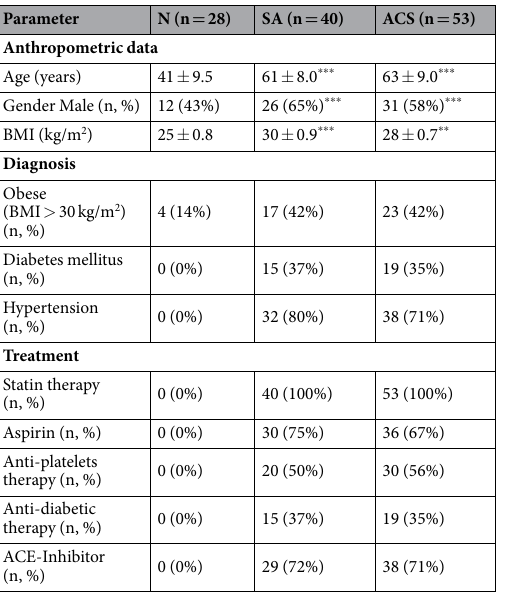
Table 1. Clinical characteristics of CAD patients and healthy subjects. N - healthy subjects, SA - stable angina patients and ACS - acute coronary syndrome patients; n - number of subjects, BMI - body mass index. Data for age are expressed as means ± standard deviation (SD). The BMI data are expressed as means ± standard error of the mean (SEM) and analyzed with two-tailed Oneway ANOVA with Least Significant Difference (LSD) Post- hoc test. Chi-squared ( χ 2 ) analysis was used to evaluate the differences between two groups of binary logistic data (gender, obesity, diabetes, hypertension, medication). ** p < 0.01, *** p < 0.001 vs. N.